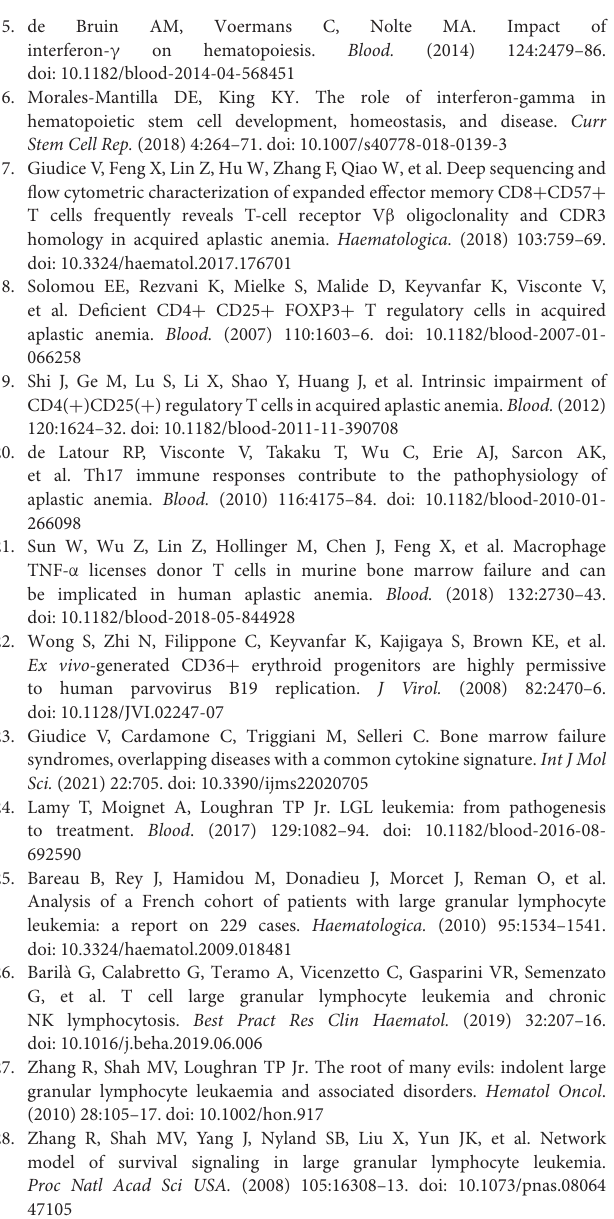
Supplementary Table 1 | CDR3 sequences for AA, PNH, and healthy subjects. CDR3, complementarity determining region 3; AA, acquired aplastic anemia; PNH, paroxysmal nocturnal